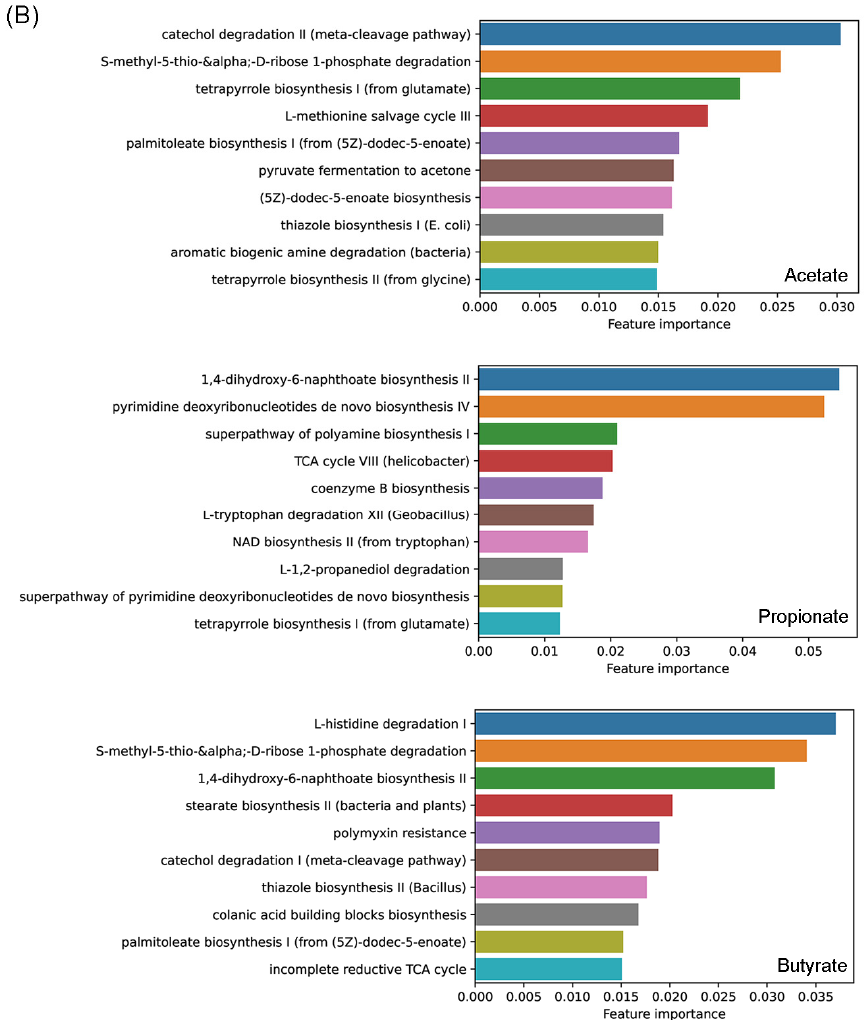
Figure 3. Important ( A ) genera and ( B ) pathways selected by feature importance in the random forest models calculated based on the mean squared errors.